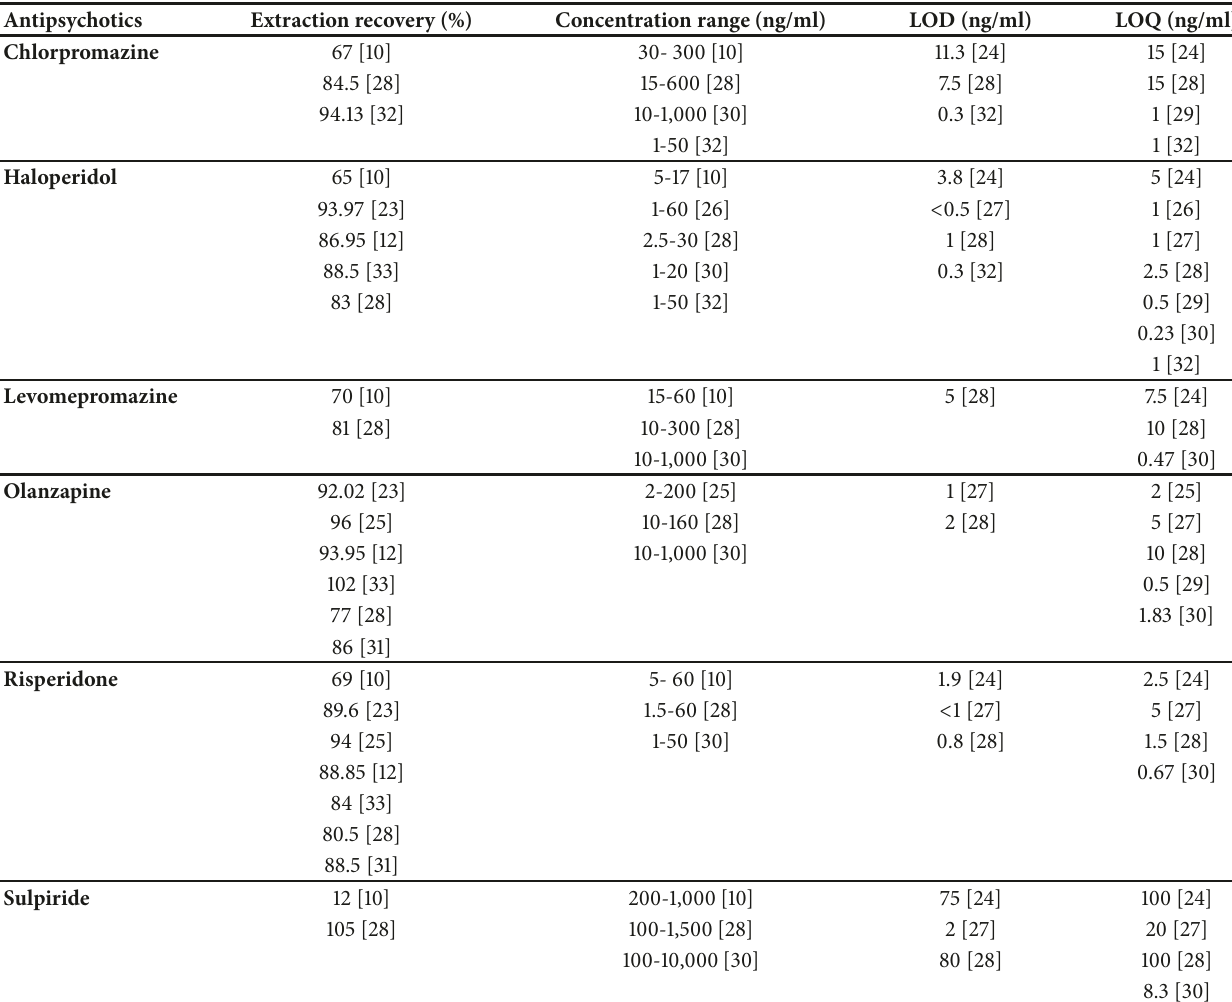
Table 6: Recovery, concentration range, LOD, and LOQ from different mass spectrometry methods.